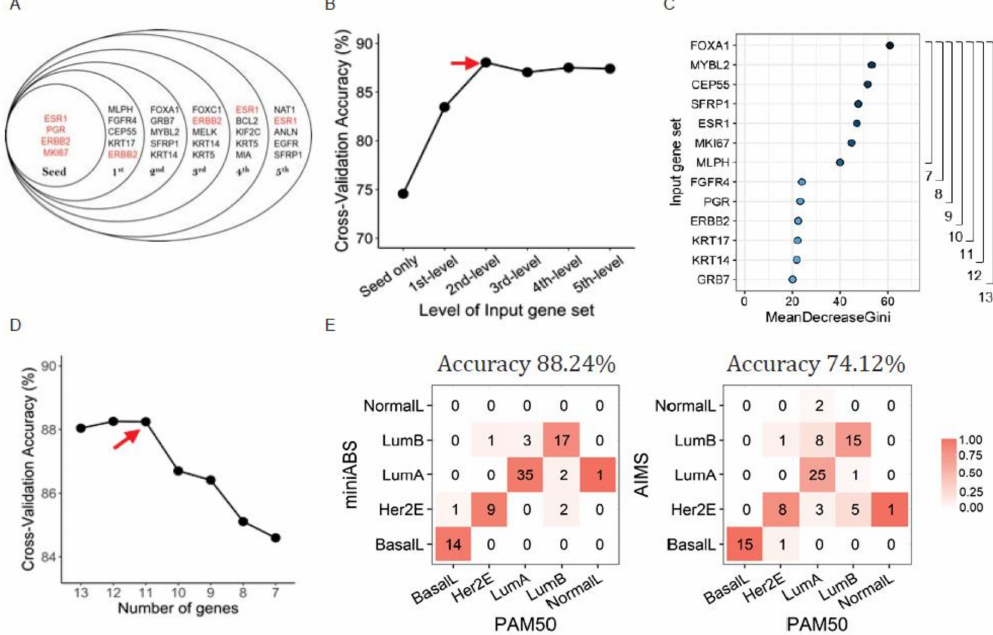
Figure 2. Optimization and performance of MiniABS. ( A ) Input gene set. The red lettering corresponds to the seed genes. ( B ) Cross-validation accuracy according to levels in the input gene set. The red arrow corresponds to best accuracy. ( C ) Mean decrease in Gini for the input gene set. Degrees of decrease in purity when splitting occurs during training after the top seven genes are reduced. ( D ) Cross-validation accuracy according to number of genes. The red arrow corresponds to best accuracy. In the case of modeling with fewer than 11 genes, we can see that the accuracy decreases sharply. ( E ) Confusion matrix of the test set ( N = 85) of TCGA BRCA. The numbers in the boxes indicate the number of samples, and the units on the color bar represent the concordance rate per subtype. The MiniABS clearly shows better overall accuracy than AIMS, and in particular, the LumA was correctly assigned the most with MiniABS than